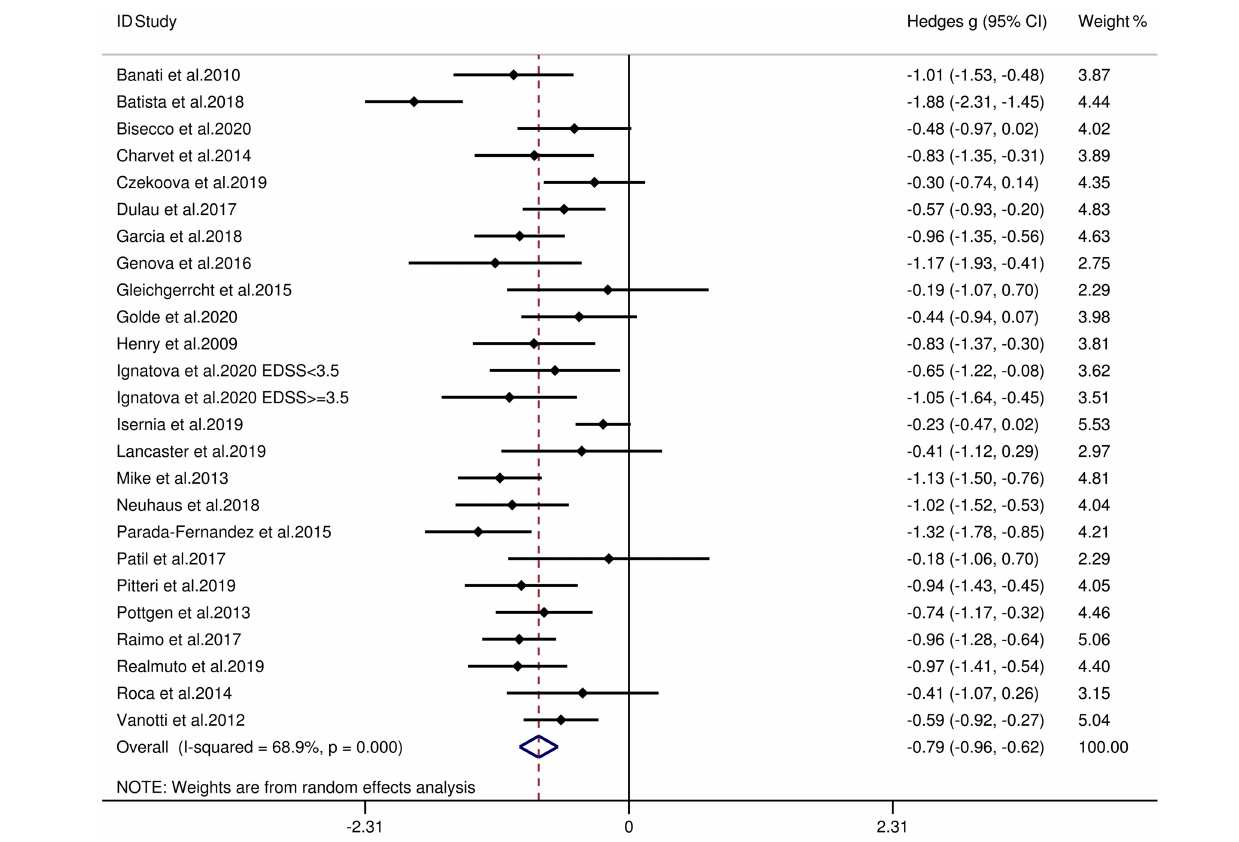
FIGURE 5 | Forest plots showing effect size estimates (Hedges g) for cognitive empathy/affective ToM differences between MS and healthy controls. CI, confidence interval; MS, multiple sclerosis; ToM, theory of mind.